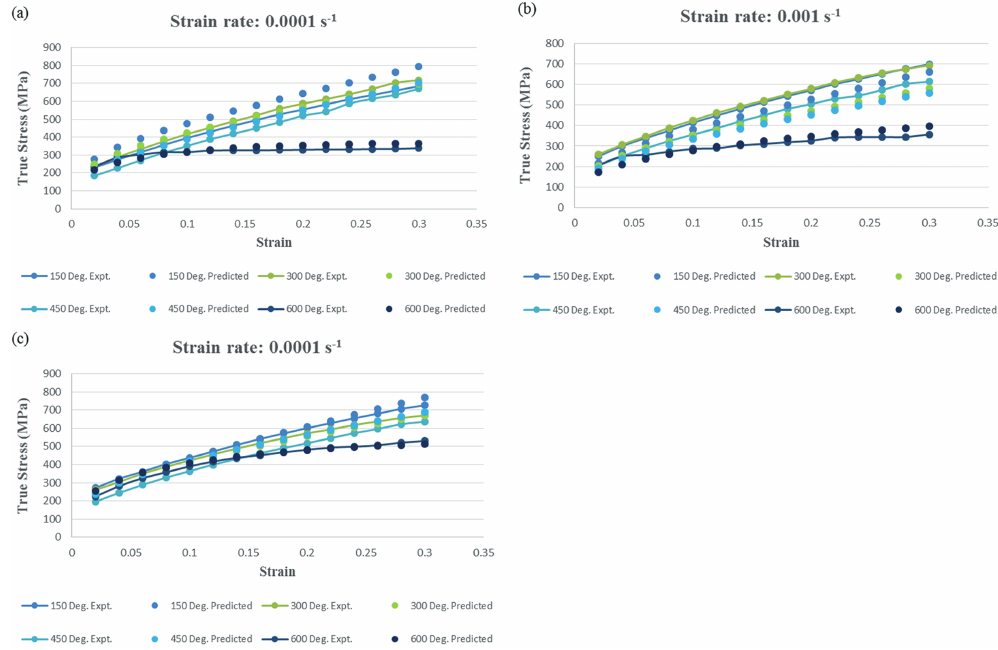
Figure 4: Comparison of experimental and predicted flow stress for m-FB model for ASS 316 for strain rates of (a) 0.0001 s − 1 (b) 0.001 s − 1 (c) 0.01 s − 1